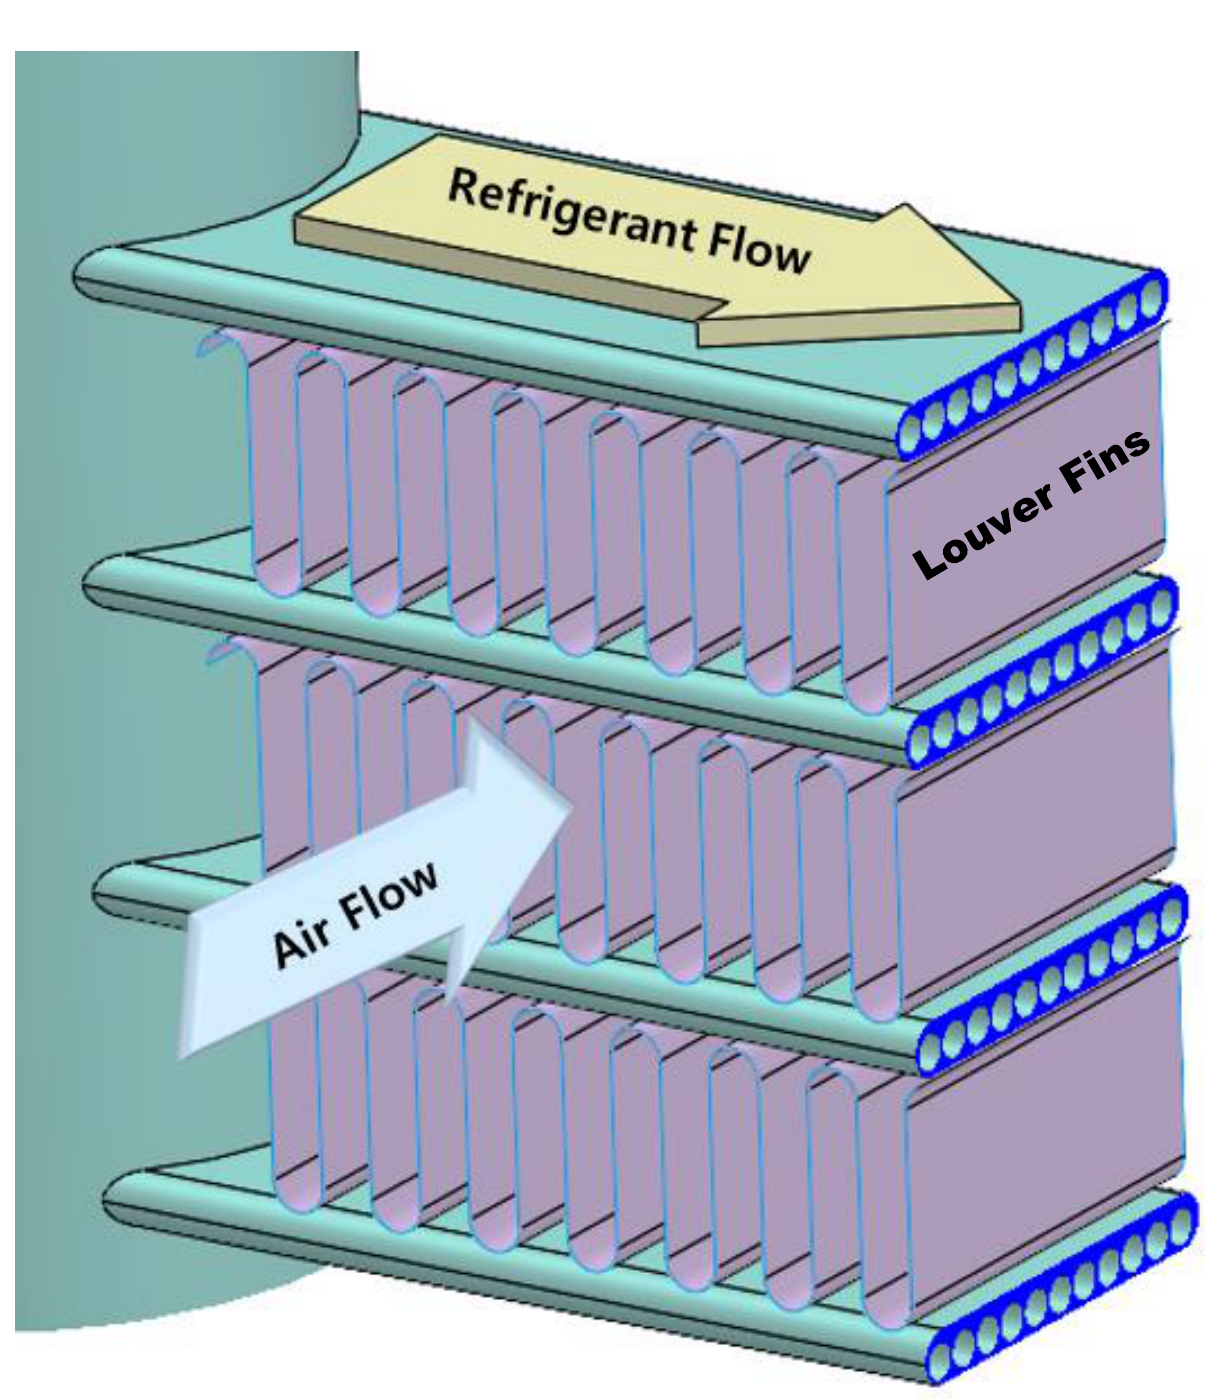
Figure 1. Schematic of the Microchannel gas cooler with flow direction.